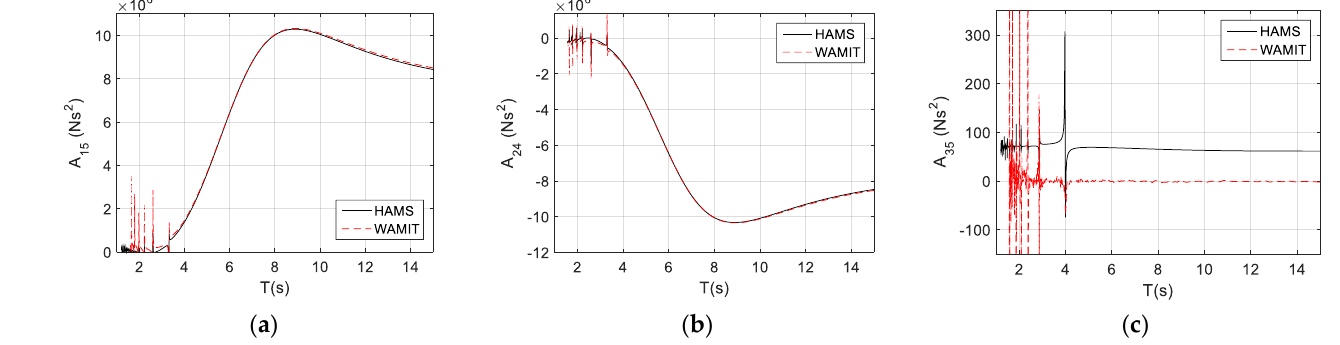
Figure 3. The coupled added mass for the TALOS structure: ( a ) for surge-pitch coupling ( 𝐴 15 ); ( b ) sway-roll coupling ( 𝐴 24 ); ( c ) for heave-pitch coupling ( 𝐴 35 ).